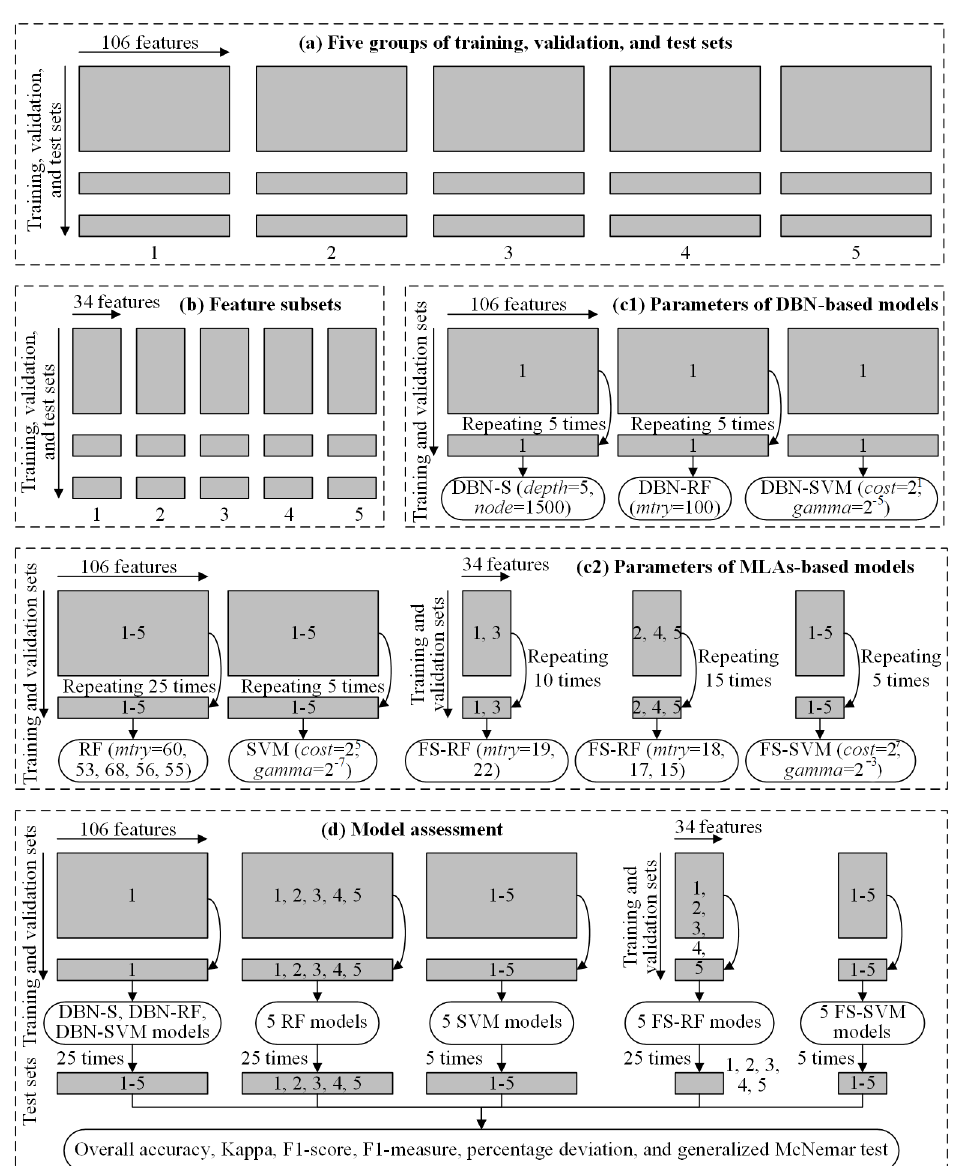
Figure 6. The used data sets and number of repeated runs in the process of feature selection (FS), parameter optimization, and accuracy assessment. DBN: deep belief network. RF: random forest. SVM: support vector machine. DBN-S: DBN with softmax classifier. DBN-RF: the fused model of DBN and RF. DBN-SVM: the fused model of DBN and SVM. MLAs: machine learning algorithms. FS-RF: RF with FS method. FS-SVM: SVM with FS